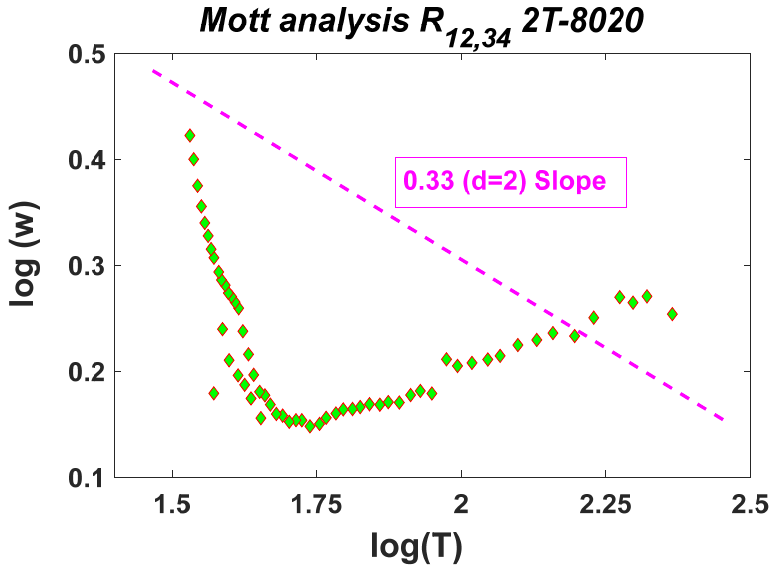
Figure A1. Plot of logarithmic derivative of resistivity versus logarithmic temperature of the R 12,34 measurement of sample 2T-8020. By the dashed purple line, the characteristic slope of a bi-dimensional material with Mott VRH transport is indicated.